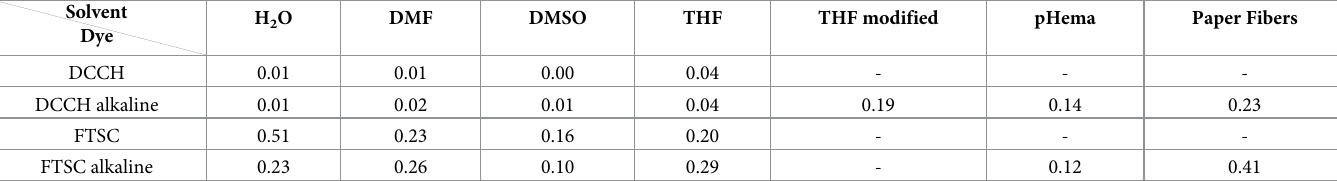
Table 1. Quantum yield [-] of DCCH and FTSC for different solvents and pH value. The QY was determined by a relative measurement. Repeated measurements yielded an error of 20%. Solvent H 2 O DMF DMSO THF THF modified pHema Paper Fibers Dye DCCH 0.01 0.01 0.00 0.04 - - - DCCH alkaline 0.01 0.02 0.01 0.04 0.19 0.14 0.23 FTSC 0.51 0.23 0.16 0.20 - - - FTSC alkaline 0.23 0.26 0.10 0.29 - 0.12